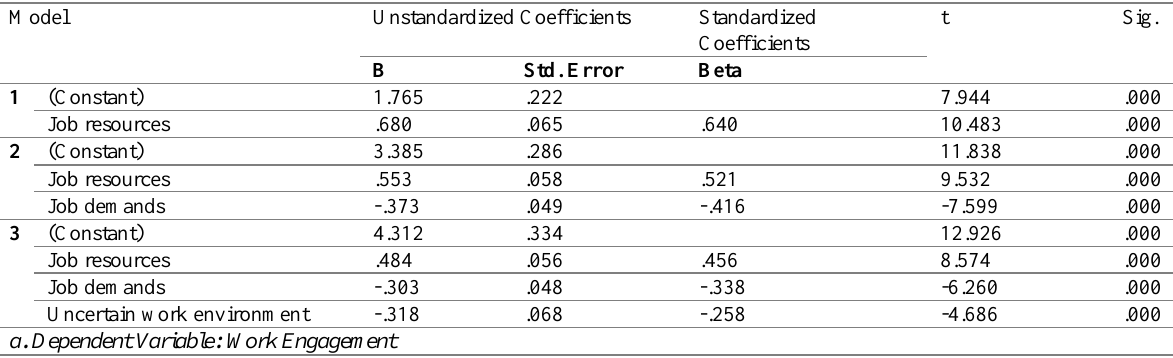
Table 10: Coefficients for the moderating effect of uncertain work environment